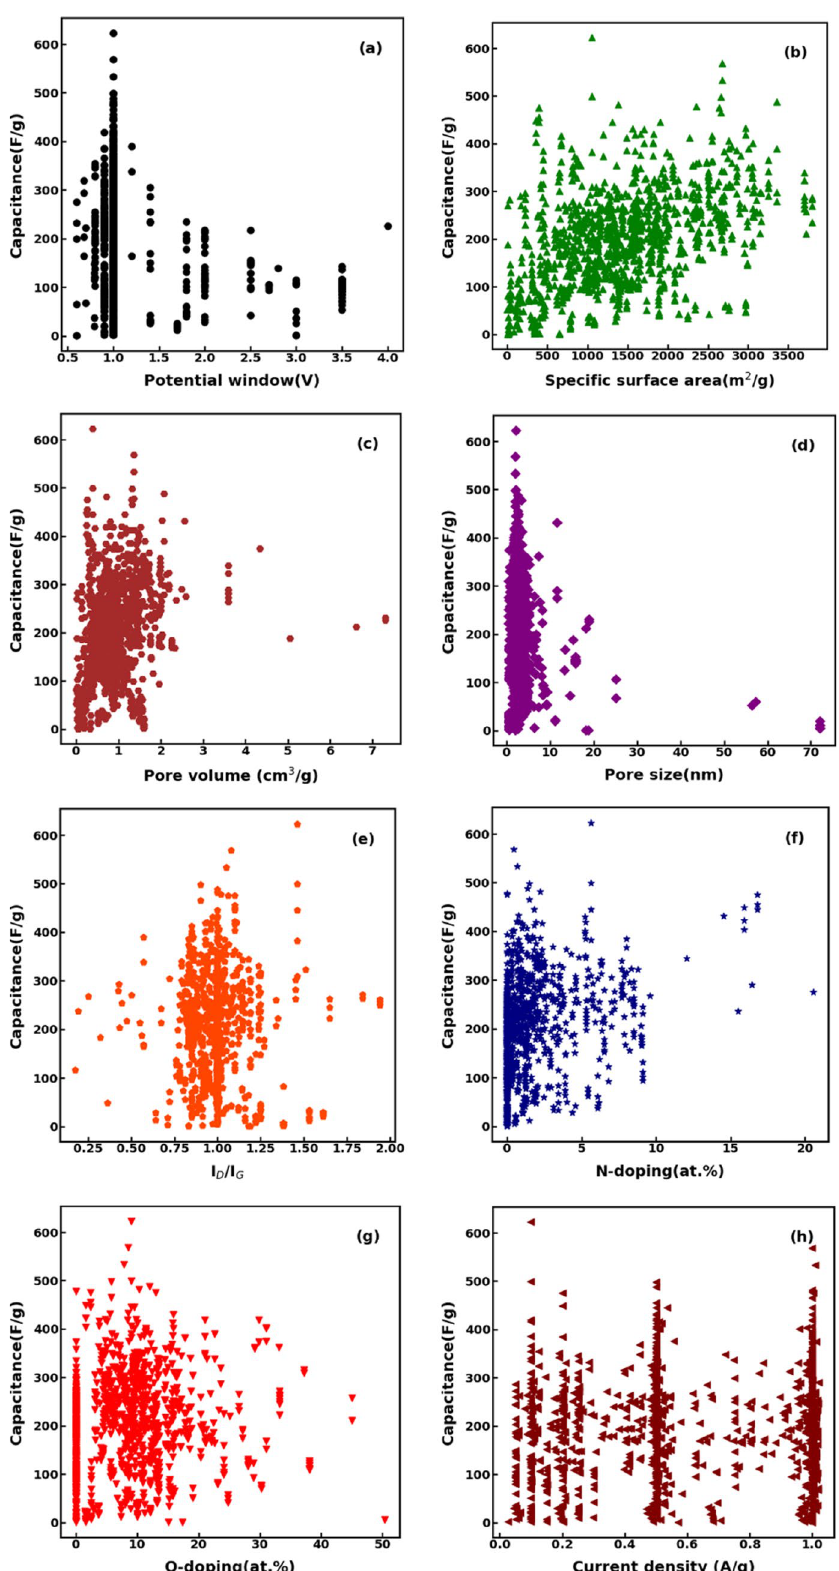
Figure 2. Relation between the specific capacitance of supercapacitors in the curated dataset and ( a ) potential window, ( b ) specific surface area, ( c ) pore volume, ( d ) pore size, ( e ) I D /I G , ( f ) N-doping (wt%), and ( g ) O-doping (wt%) at current density of I = 1 A/g. (h) Relationship between specific capacitance and different current